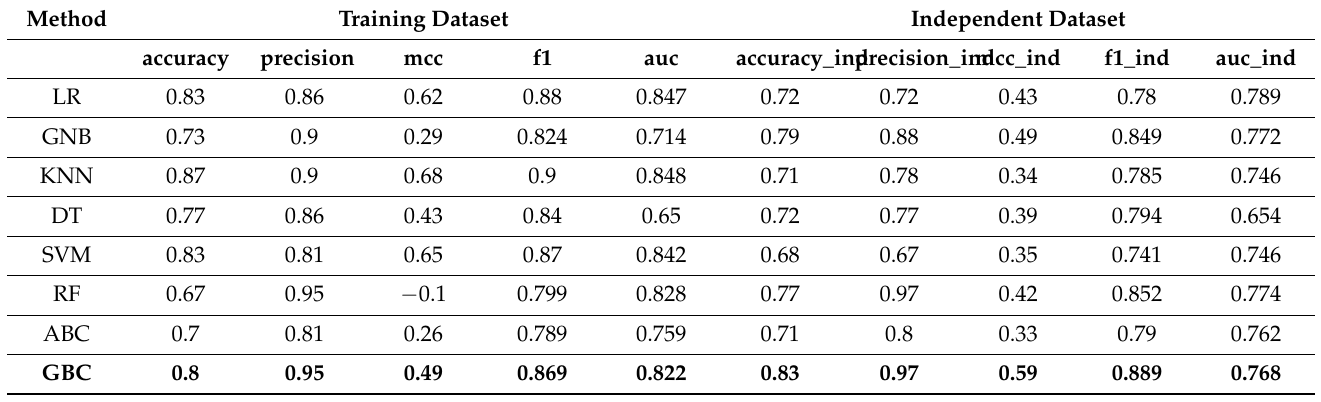
Table 2. Performance measures of the AAC and DPC features using the training and the independent datasets.